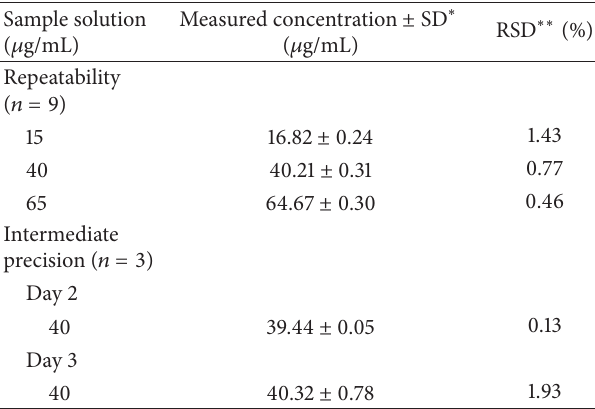
Table 4: Repeatability and intermediate precision data for ferulic acid analysis.